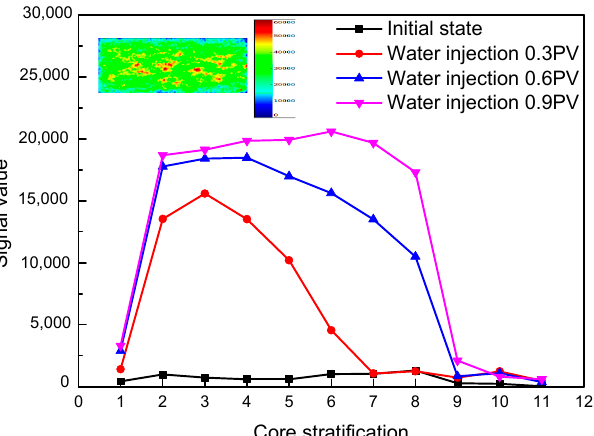
process of the high-permeability core. The length of the core sample is 5 cm, and the lay- ered area is twice the length of the sample. As shown in the figure, the signal value is Figure 4. Variation trend of stratified nuclear magnetic signal during water flooding and NMR Figure 4. Variation trend of stratified nuclear magnetic signal during water flooding and NMR im- imaging after saturated water in high-permeability distribution of fluid in the core can be directly observed by nuclear magnetic resonance aging after saturated water in high-permeability cores. imaging.